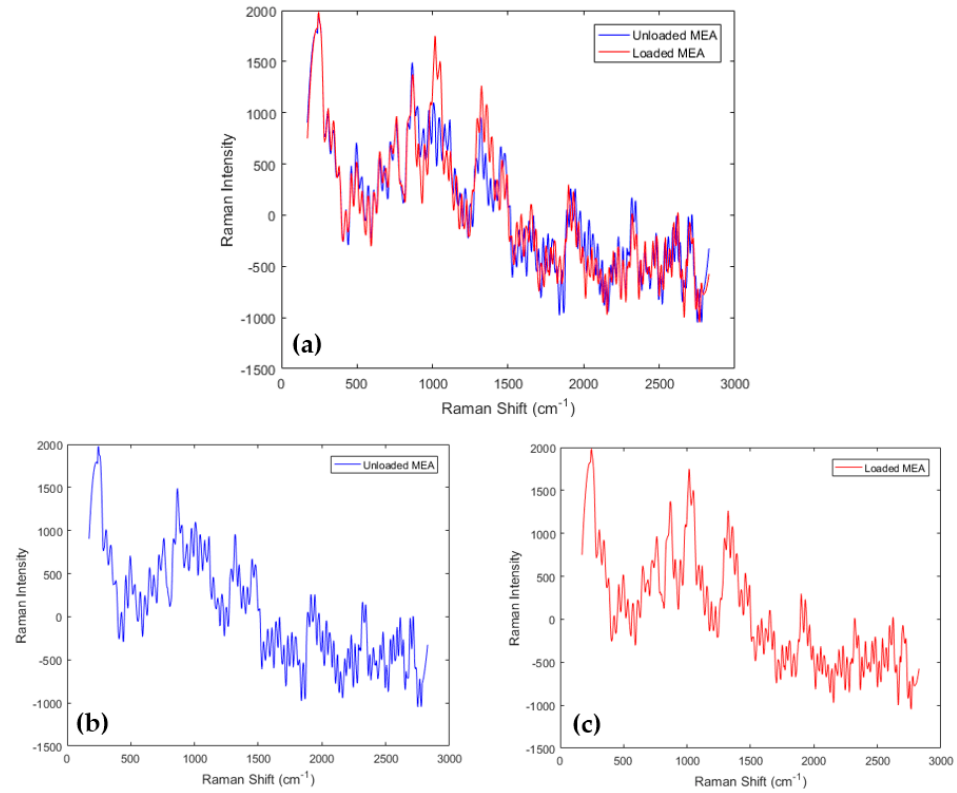
Figure 4. Plots of Raman spectra captured from unloaded and CO 2 ‐ loaded aqueous monoethanolamine (MEA) solution. Each are for ( a ) combined plot, ( b ) unloaded MEA, and ( c ) loaded MEA. For the ionic species, the characteristic band for bicarbonate ion is visible at 1017 cm − 1 (C–OH stretching) while the characteristic band for carbonate is located at 1065 cm − 1 (C–O bond stretching). The characteristic band for carbamate is observed at 1162 cm − 1 (C ‐ N stretching) and for protonated MEA at 1011 cm − 1 (CH 2 twisting), 1274 cm − 1 (C–NH stretch) and 1320 cm − 1 (C–C stretch). For non ‐ ionic species, the dissolved CO 2 characteristic bands are observed at 1274 cm − 1 (CO 2 symmetric stretch) and 1383 cm − 1 (CO 2 bend), while the band for unreacted MEA is observable at 845 cm − 1 (CH 2 rocking) and 873 cm − 1 (CN stretching) [4,6,12,50,51].